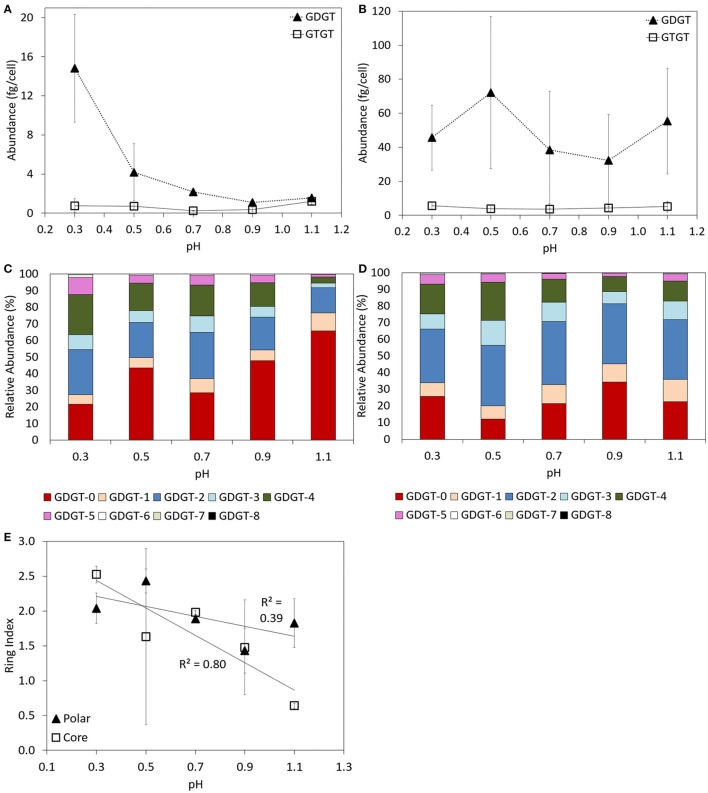
Abundance of GDGT and GTGTs per cell in the core (A) and polar (B) fractions of batch cultures of P. torridus grown in cultivation medium with varying pH. Relative abundance of individual GDGT lipids in the core (C) and polar (D) lipid fractions of log phase cells of P. torridus grown in cultivation medium with varying pH. Calculated ring indices for log phase cultures of P. torridus grown in cultivation medium with varying pH (E). All cultures were incubated at 58°C. Error bars in panels (A,B,E) represent the standard deviation of three replicate cultures.